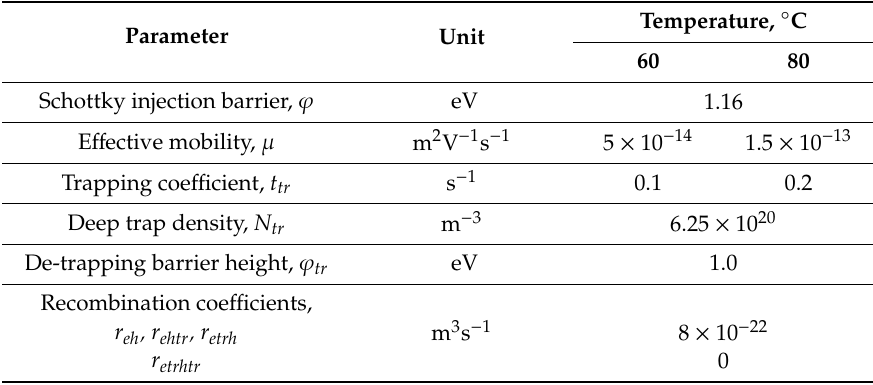
Temperature, ◦ C 60 80